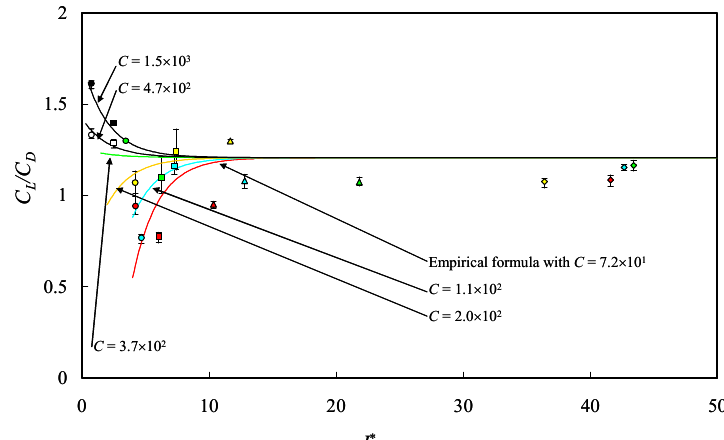
Fig. 9 Lift-drag ratio C L / C D versus inertia moment ratio I * , for λ = 0.3, AR = 10, C = 7.2 × 10 1 − 1.6 × 10 3 and I * = 0.75 − 43. Empirical formula is described as Eq.